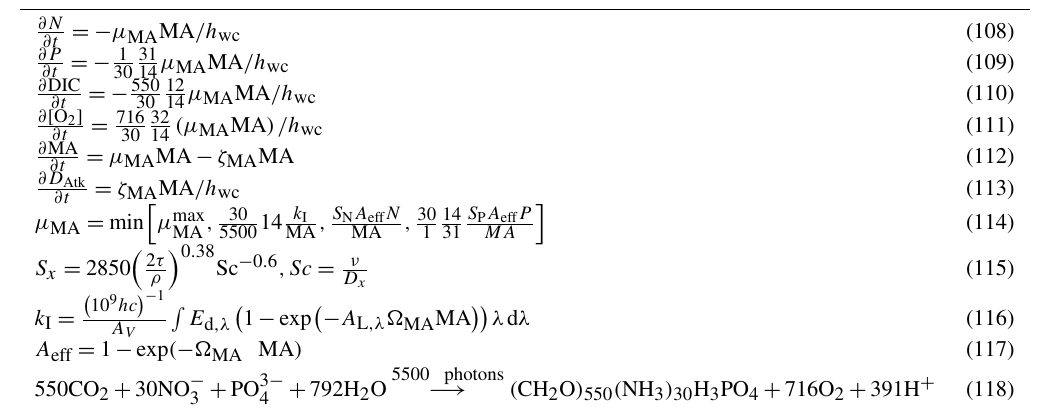
Table 19. Equations for the macroalgae model. Other constants and parameters are defined in Table 20: 14gNmolN − 1 ; 12gCmolC − 1 ; 31gPmolP − 1 ; 32gOmolO 2 − 1 . Uptake shown here is for nitrate; see Sect. 9.1 for ammonium